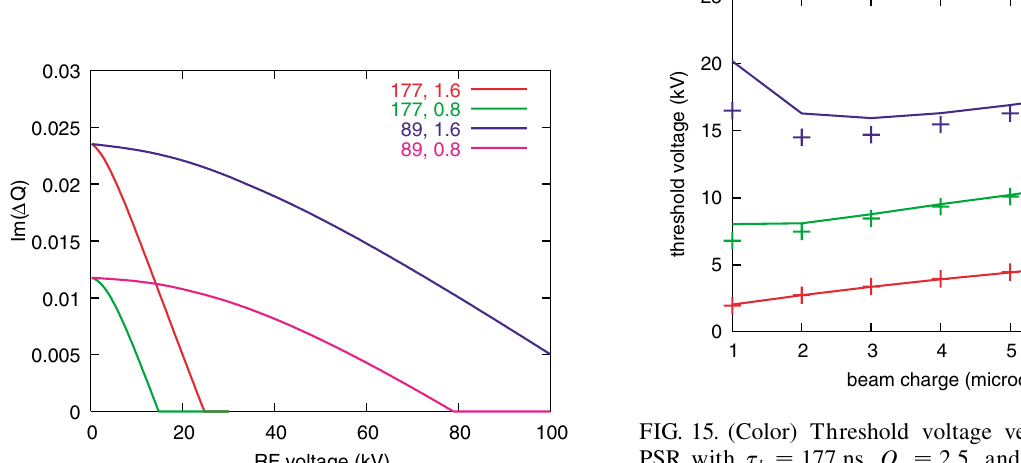
FIG. 15. (Color) Threshold voltage versus bunch charge for (cid:5) 177 ns , Q (cid:5) 2 : 5 , and electron line densities PSR with (cid:6) b r of 0 : 1 , 0 : 5 , and 1 : 0 nC = m . The symbols are the thresholds for M (cid:5) 5 and N (cid:5) 5 . The solid line is the estimate using the coasting beam dispersion relation, Eq. (18), and the M (cid:5) 5 tune distribution.